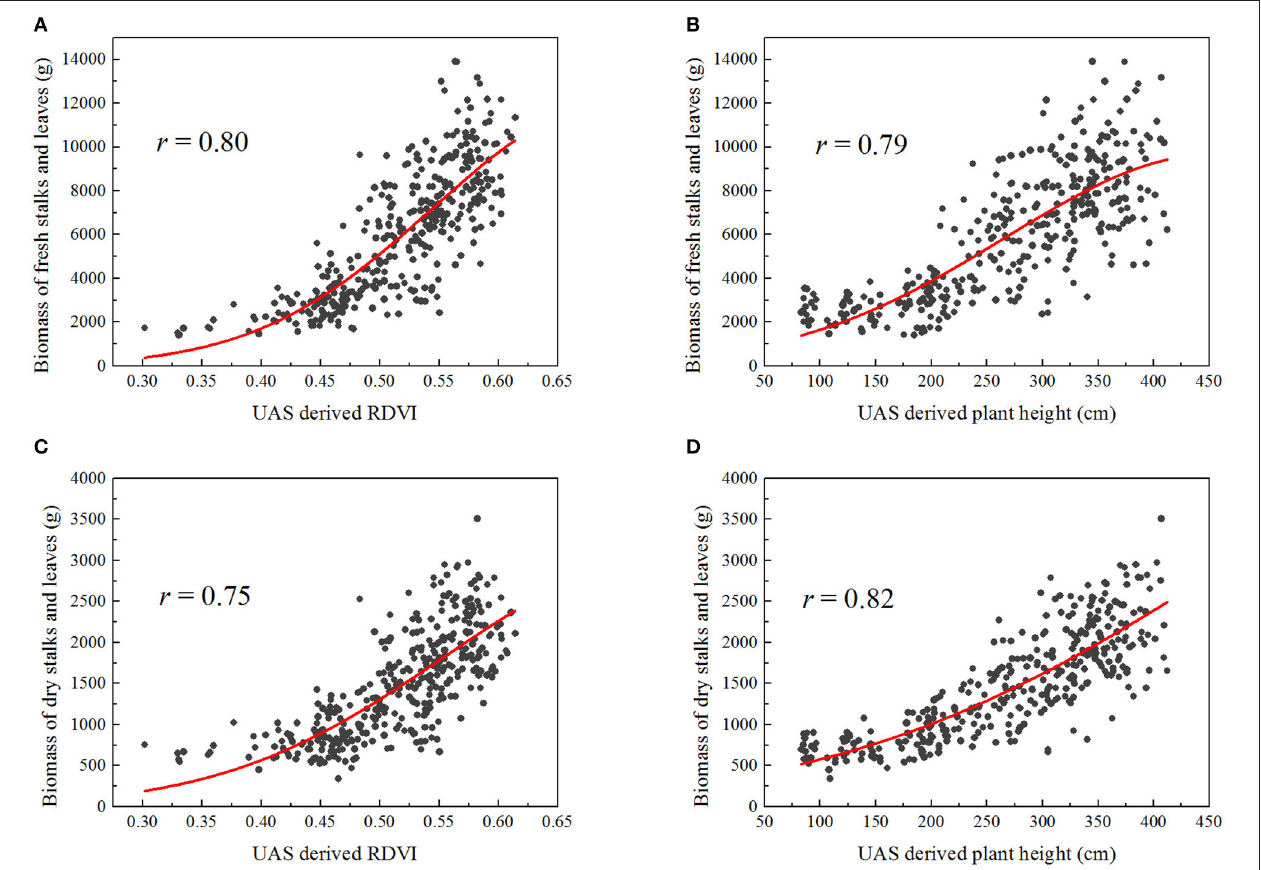
FIGURE 5 | Exponential correlations between some UAS-derived traits and the manually sampled biomass of stalks and leaves (fresh or dry), over 363 plots: (A) RDVI and fresh biomass, (B) plant height and fresh biomass, (C) RDVI and dry biomass, (D) plant height and dry biomass.